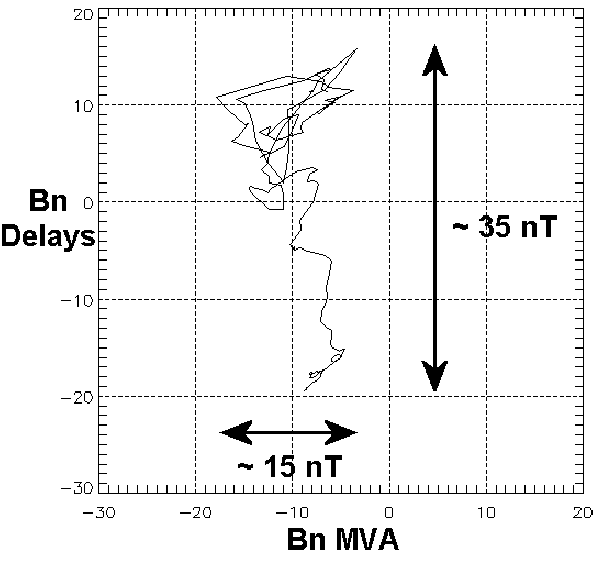
Figure 6. This figure shows an hodogram-type plot of the normal magnetic field components arising Fig. 6. This figure shows a hodogram-type plot of the normal mag- from the MVA and time-delay techniques against each other, for the SEC-magnetosheath boundary on netic field components arising from the MVA and time-delay tech- 23/03/2002. It appears that the multi-spacecraft time-delay technique yields a very variable normal niques against each other, for the SEC-magnetosheath boundary on field component that largely changes, and in particular of sign, across the boundary while the 23/03/2002. It appears that the multi-spacecraft time-delay tech- component arising from MVA is much less variable and persistently negative. nique yields a very variable normal field component that changes greatly, particulary regarding the sign, across the boundary while the component arising from MVA is much less variable and persis- tently